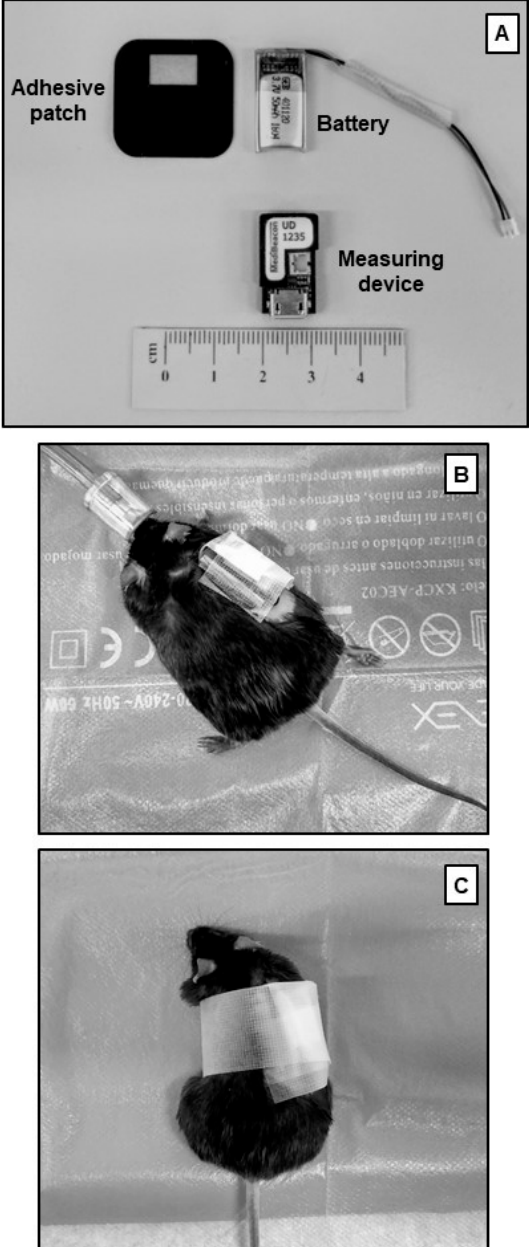
Figure 1. Transcutaneous glomerular filtration rate measurement technique. ( A ) Transcutaneous measuring device and its components. ( B ), The device is placed in the shaved back of the mouse anesthetized with isoflurane. Adhesive tape is also used to properly fix the device and avoid movement artefacts. ( C ), Once attached and after fluorescein isothiocyanate (FITC)-sinistrin administration, the mouse can move freely during measuring period.